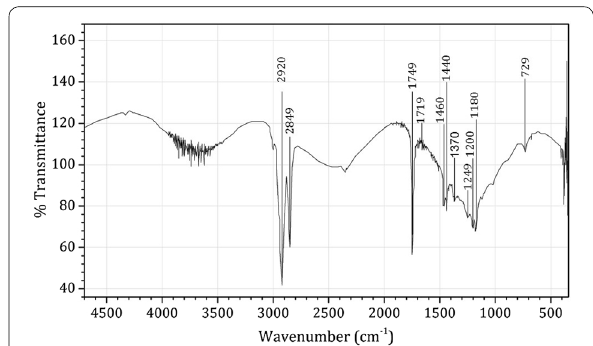
Fig. 8 Fourier Transform Infrared Radiation (FTIR) spectrum of biodiesel